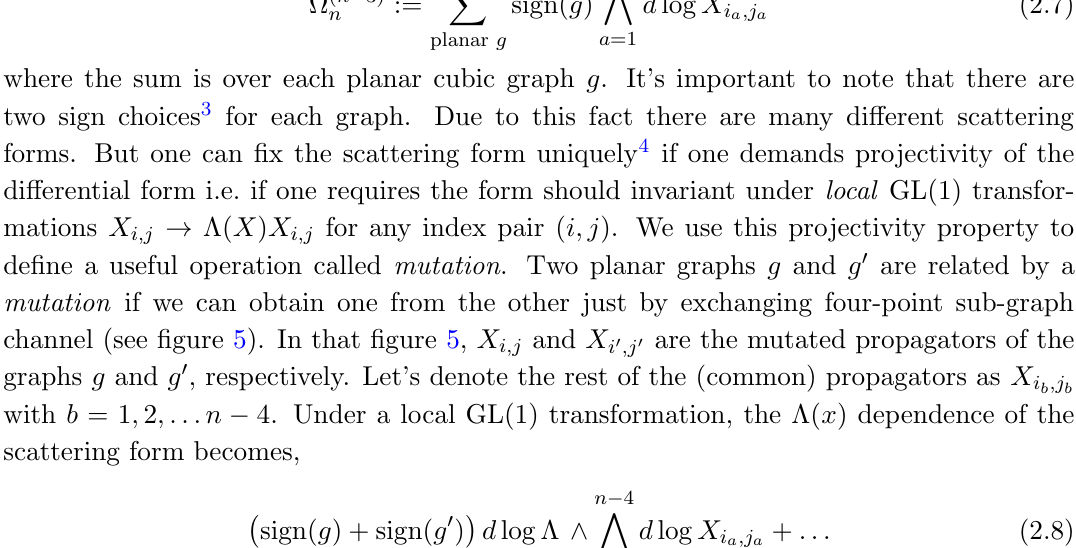
Figure 4 . Two dimensional associahedron onals. 5 complete triangulations are represented by 5